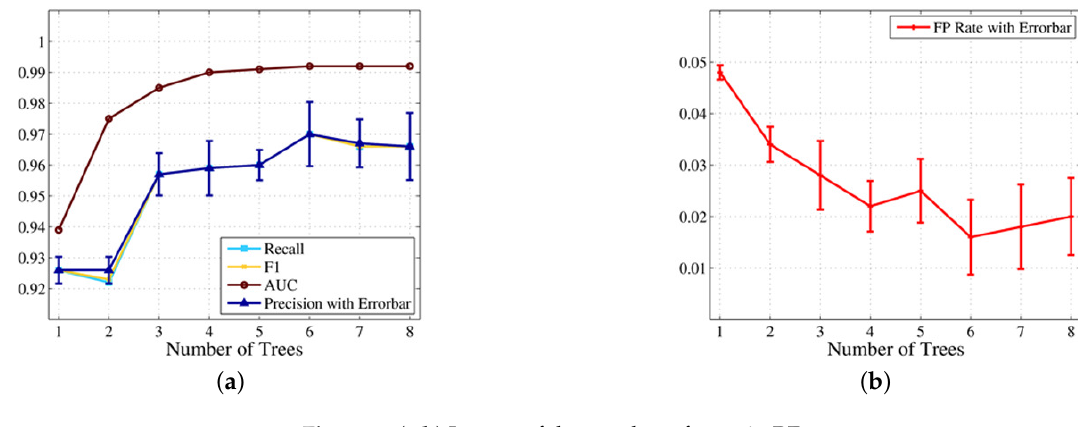
Figure 9. ( a , b ) Impact of the number of trees in RF.